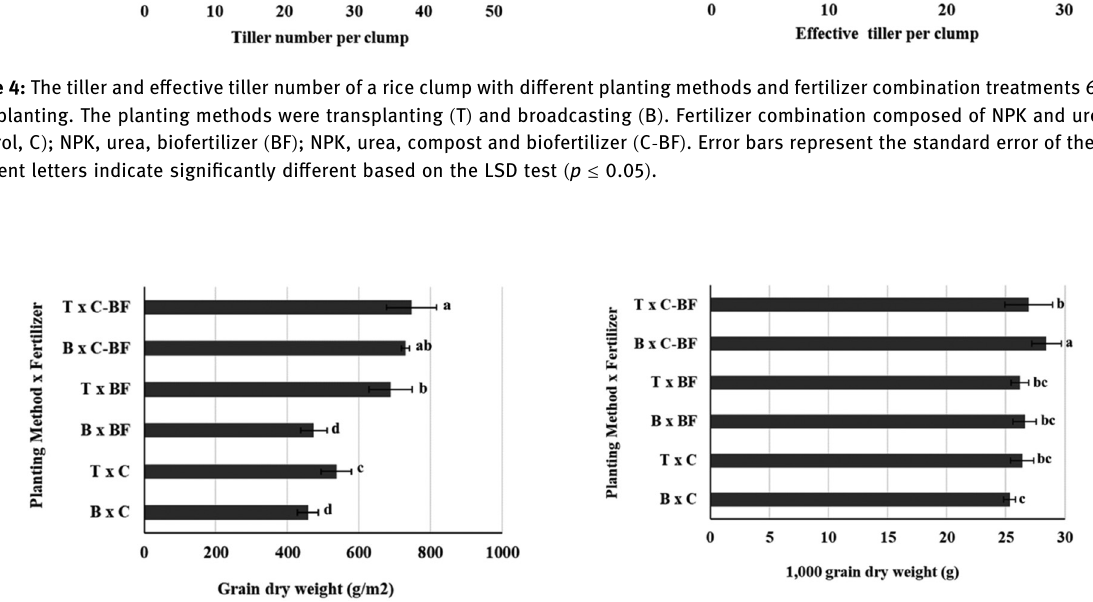
Figure 5: The GDW and 1,000 - grain weight with di ff erent planting methods and fertilizer combination treatments 60 days after planting. The planting methods were transplanting ( T ) and broadcasting ( B ) . Fertilizer combination were NPK and urea ( control, C ) ; NPK, urea, biofertilizer ( BF ) ; NPK, urea, compost and biofertilizer ( C - BF ) . Error bars represent the standard error of the mean. Di ff erent letters indicated the signi fi cantly di ff erent based on the LSD test ( p ≤ 0.05 )